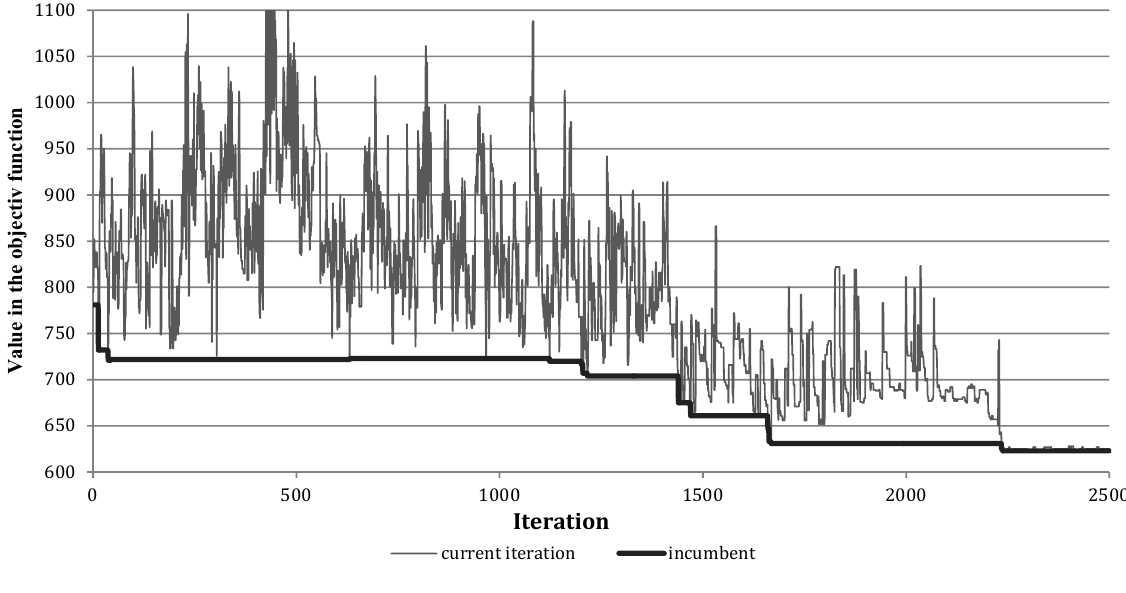
Fig. 6. Behavior of convergence of the algorithm. Instance evaluated